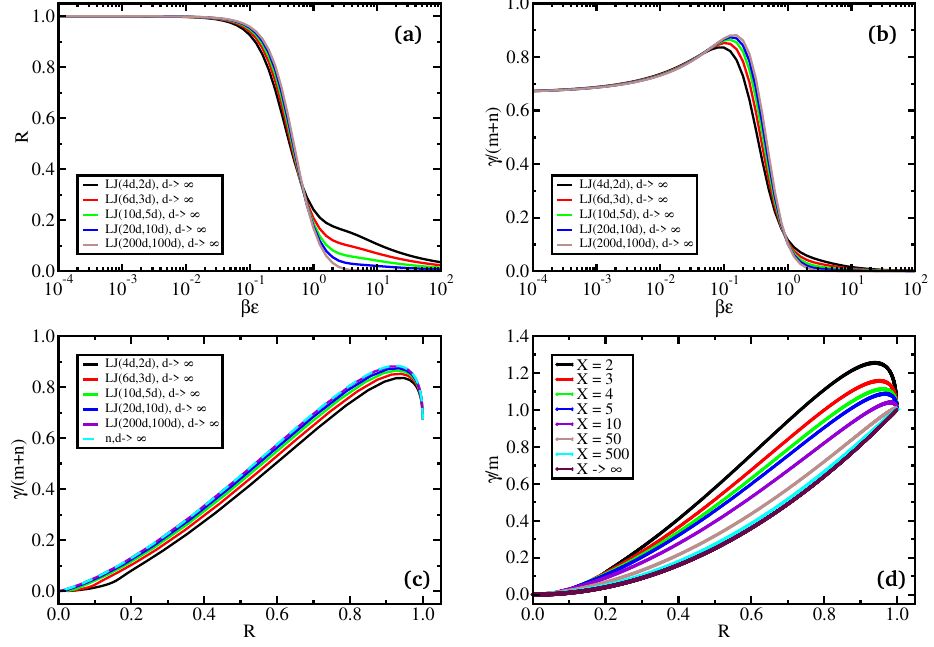
Figure 2: Results from the analytic expressions Eq. (13) derived in the first-order virial approximation (hereafter labelled d → ∞ , see 3.2) in any dimension d . (a)(b)(c) examine LJ ( 2 nd , nd ) potentials with varying n = 2 → ∞ . The